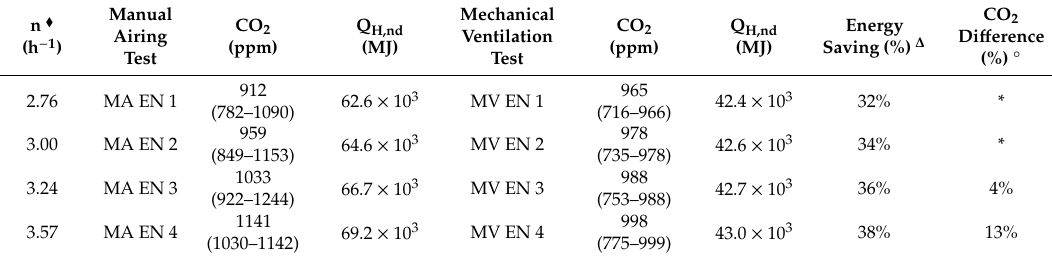
Figure 7. CO 2 trends estimated manual airing (MA EN 1–MA EN 4) and mechanical ventilation (MV EN 1–MV EN 4) as a function of the crowding index of the classroom when the same air exchange rate is adopted. Table 4. Comparison between manual airing and mechanical ventilation tests in terms of CO 2 concentrations and energy needs ( Q H,ve , Q H,nd ) estimated for the test-classroom for different required values of air exchange rates ( n ).